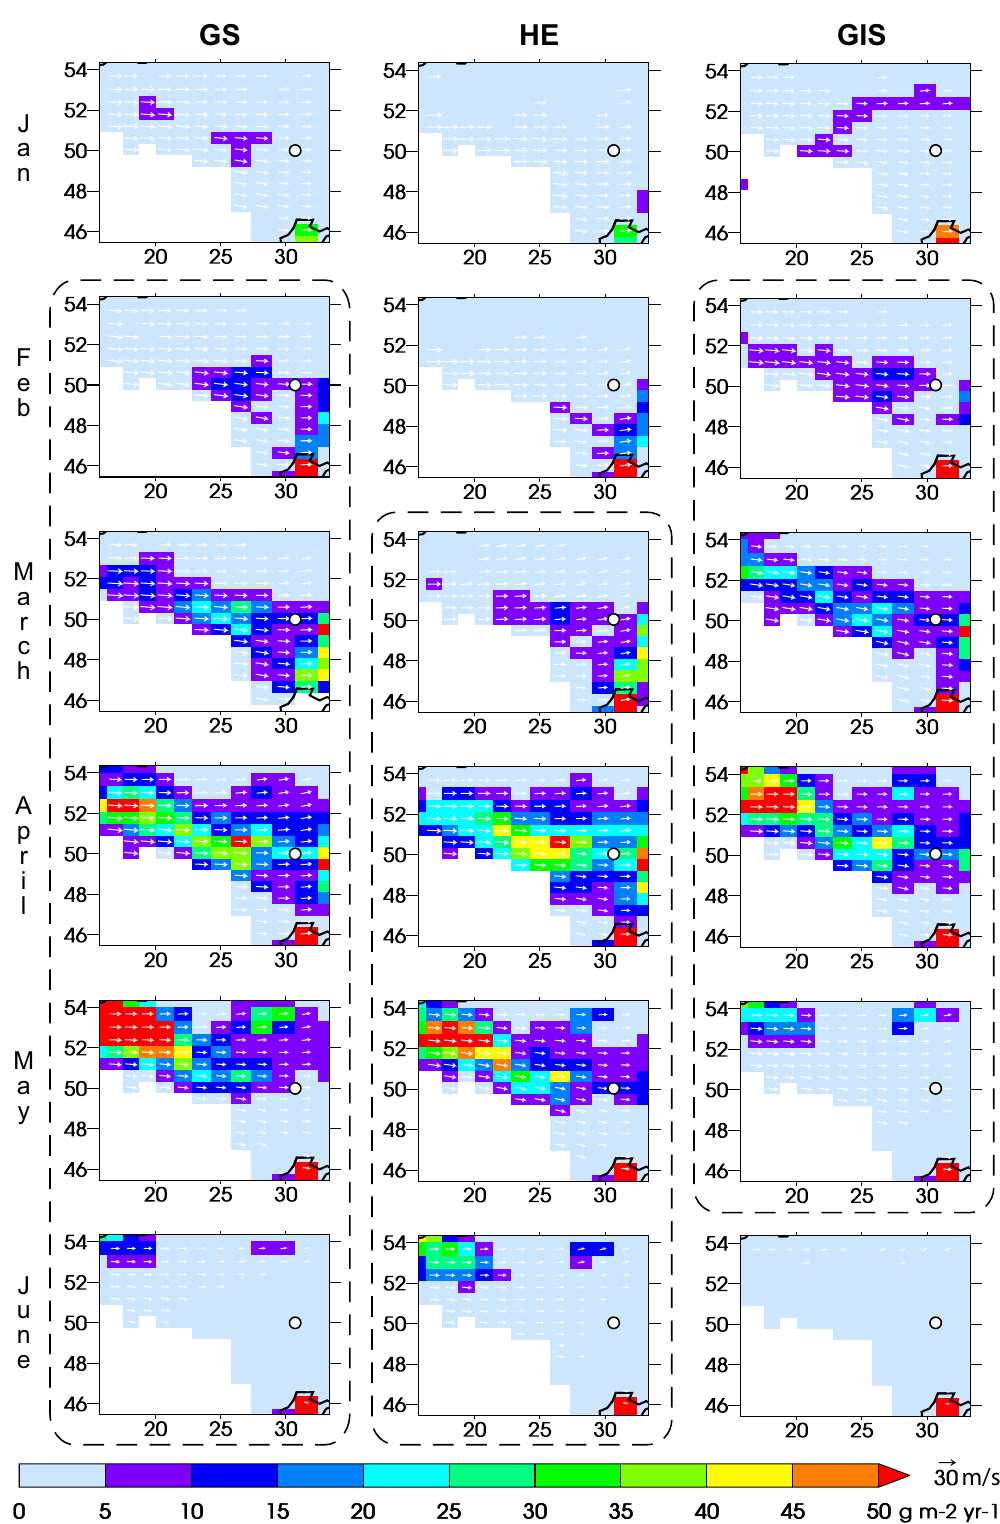
Fig. 6. Monthly means of dust emission fluxes outside the Carpathians in the three simulated climate states for January to June (for each panel, the x-axis represents longitude ( ◦ E), and the y-axis latitude ( ◦ N)). Wherever the slightest emission occurs, the monthly average wind vectors at 850hPa indicate the direction in which the dust is most likely transported. Little or no dust is emitted in this area during the rest of the